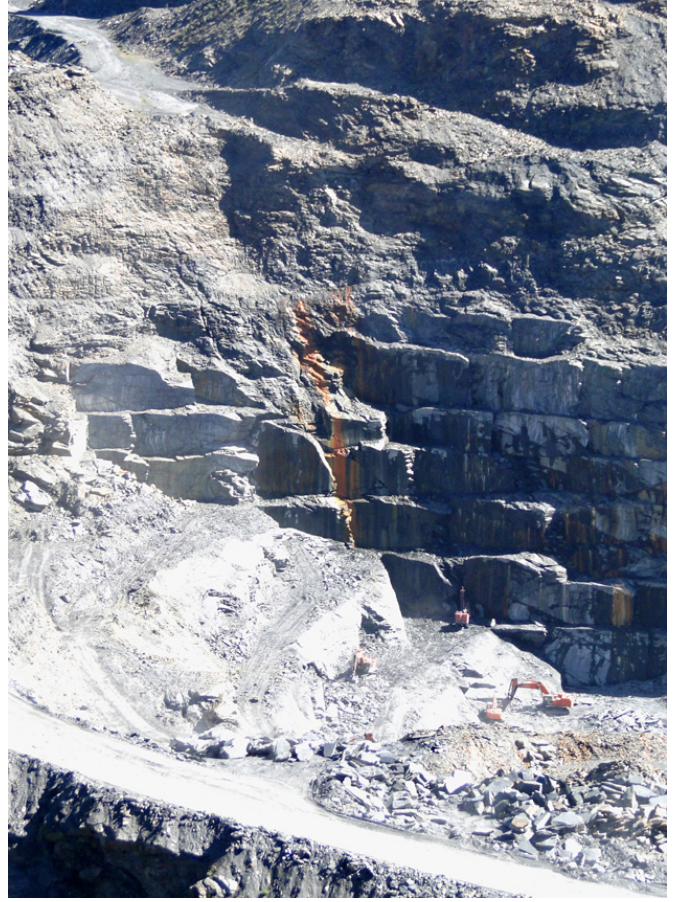
Figure 4. Opencast slate mining in Spain (Valdeorras, Luarca slate).